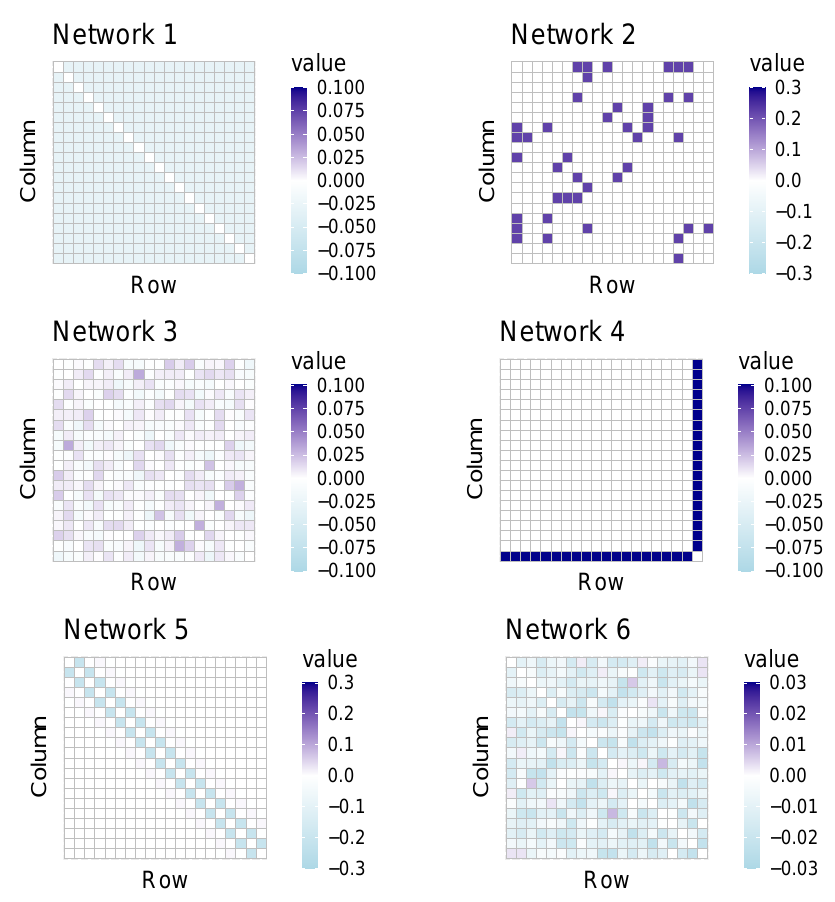
Figure A1. Precision matrices (diagonal elements